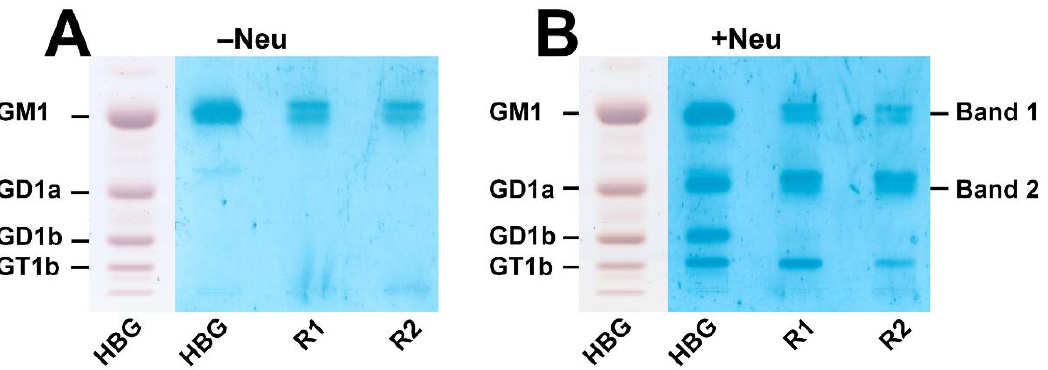
Figure 4. Detection of GM1 in two ganglioside preparations of pHCoEpiCs before ( A ) and after treatment with neuraminidase of Vibrio cholerae ( B ). GM1 was detected without ( − Neu) and after neuraminidase treatment (+Neu) by means of the TLC overlay assay using choleragenoid (cholera toxin B subunit). Amounts of 15 µ g of human brain gangliosides (HBG) were applied for the orcinol stains (left lanes of panel A and B). For the TLC overlay assays without ( − Neu) and after neuraminidase treatment (+Neu) 0.2 µ g of HBG and ganglioside amounts of the two replicates R1 and R2 of pHCoEpiCs, each corresponding to 2 × 10 5 cells, were applied. HBG served as positive control for the TLC overlay assay. Structures of GM1, GD1a, GD1b and GT1b are depicted in Figure 1. Mass spectrometric characterized gangliosides obtained from the silica gel extracts of TLC bands at the positions of GM1 and GD1a (see Figure 5), assigned as band 1 and band 2, respectively, are listed in Table 2.